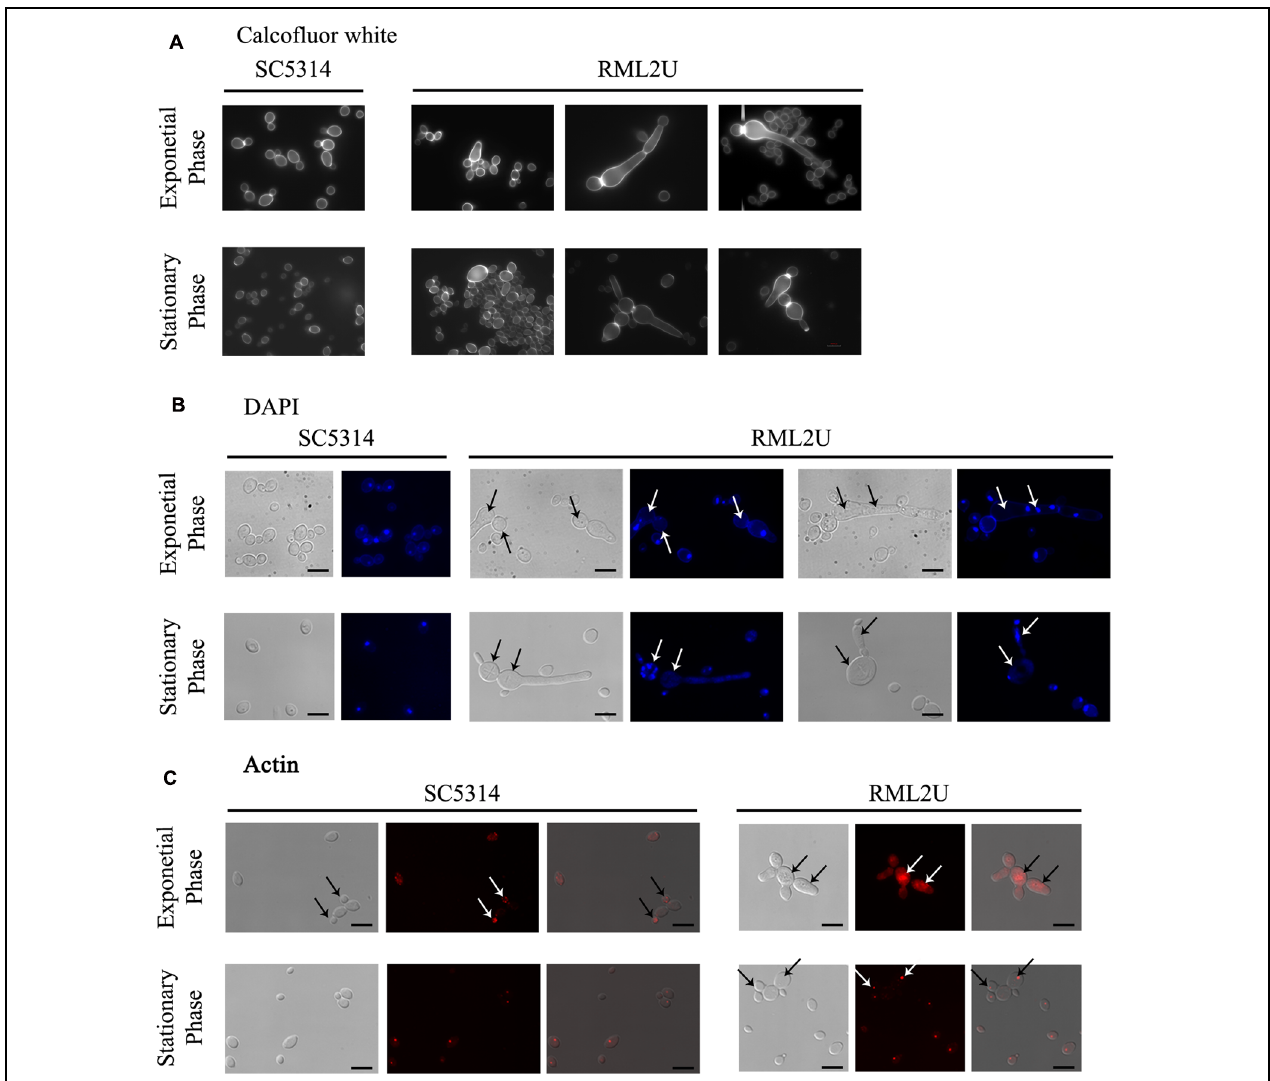
FIGURE 3 | Ecm33 is important for nuclear DNA division, septa distribution and actin polarization during C. albicans growth. (A) calcofluor staining was used to visualize the chitin localized in the septum. (B) The nuclear DNA was observed by labeling with DAPI, a highly specific stain for DNA. Arrows indicate defects in the number of nuclei. (C) C. albicans strains were fixed and stained with Alexa phalloidin to visualize actin. Arrows in SC5314 indicate normal actin polarization in buds, compared to